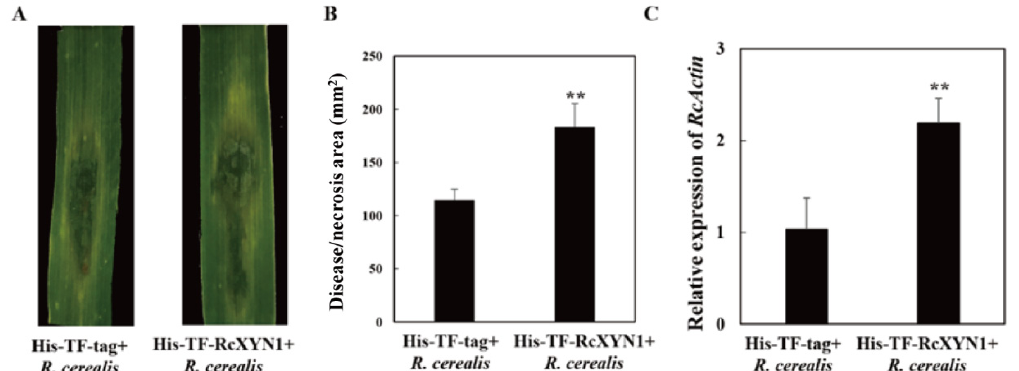
Figure 8. Contribution of RcXYN1 to pathogenicity in R. cerealis infection of wheat. ( A ) His-TF-RcXYN1 enhanced pathogenic phenotypes of R. cerealis in wheat leaves. Pictures of the lesions were taken at 3 days post inoculation with the fungus and the lesion area was measured; ( B ) Disease severity measured as area of necrosis induced by R. cerealis mycelia on leaves shown in ( A ); ( C ) RT-qPCR measurement of the pathogen and wheat RNA ratios were used to determine the R. cerealis relative biomass in infected plant tissues shown in ( A ). Three independent biological replicates were conducted. Error bars were calculated based on three replicates. ** indicates a significant di ff erence between His-TF-RcXYN1 treatment and His-TF-tag treatment ( t -test; p <